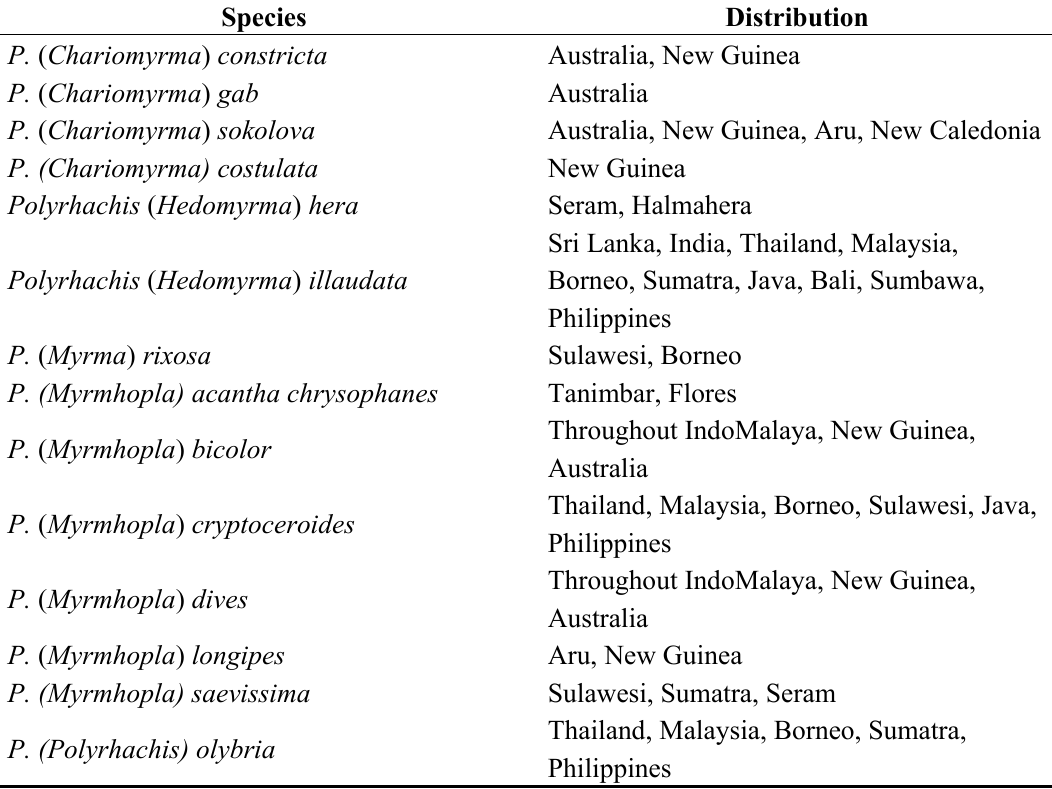
Table 3. Previously known distributions of named species from Timor and surrounding